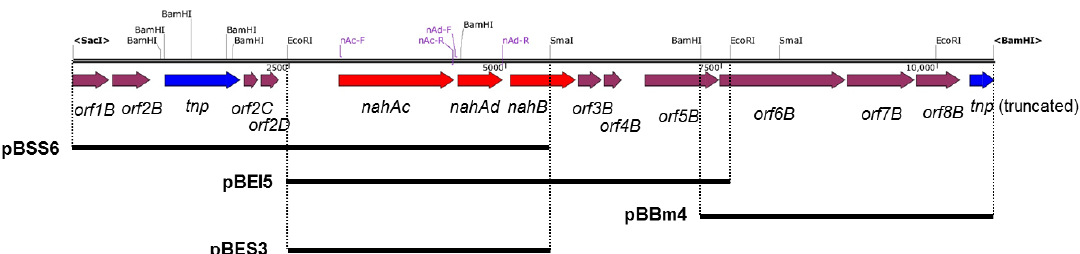
Figure 2. Genetic organization of the nah gene cluster of strain JF8. Red, blue, and magenta pentagons indicate naphthalene-degradative genes, transposase gene, and genes for hypothetical proteins. Restriction enzyme site and positions for primers are shown. The solid black bars under the map indicate DNA regions cloned into each plasmid.